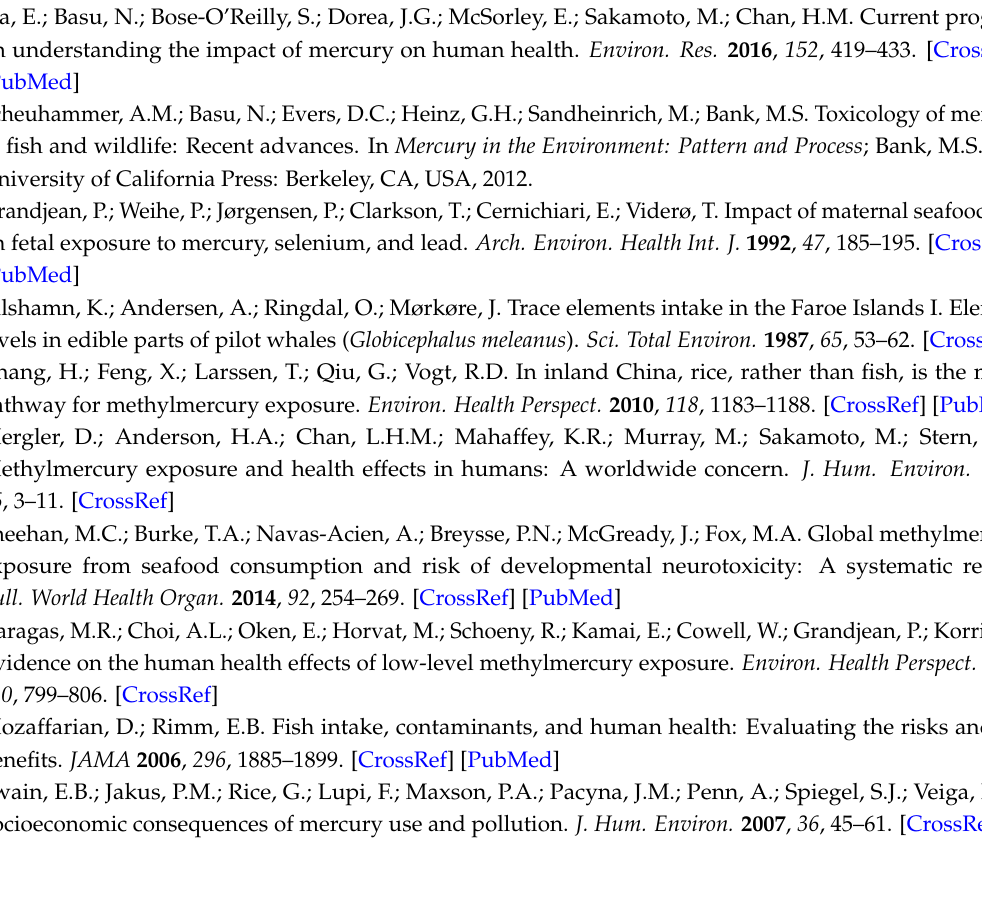
Figure S1: Case study of MeHg bioaccessibility from tuna, Figure S2: Case study of Hg(II) bioaccessibility from tuna, Table S1: MeHg and Hg(II) assimilation efficiency for various fish species, Table S2: Key for studies for Figure 2, Table S3: Bioaccessibility of MeHg and Hg(II) to humans from various fish, Table S4: Key for studies for Figures 3 and 4, Table S5: Absorption of MeHg and Hg(II) to humans from various